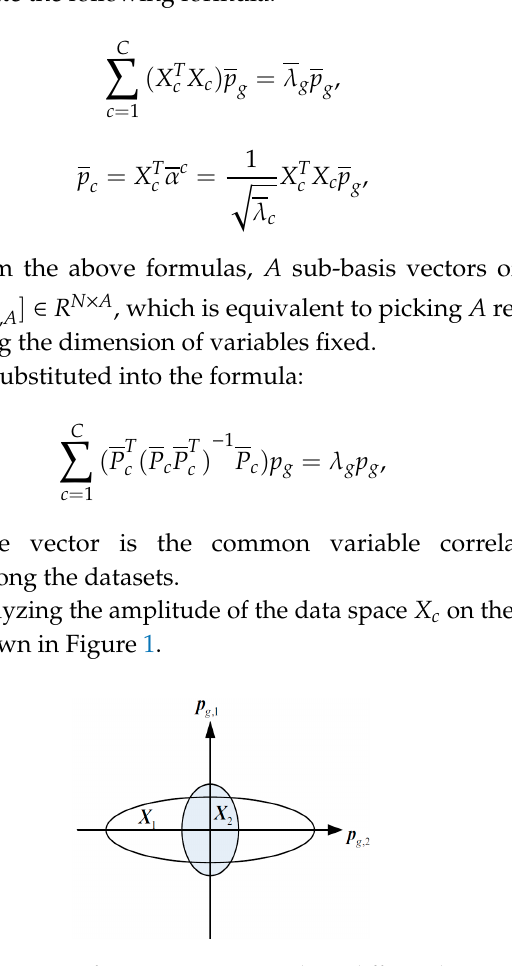
Figure 1. Schematic of process variations along different basis vectors.